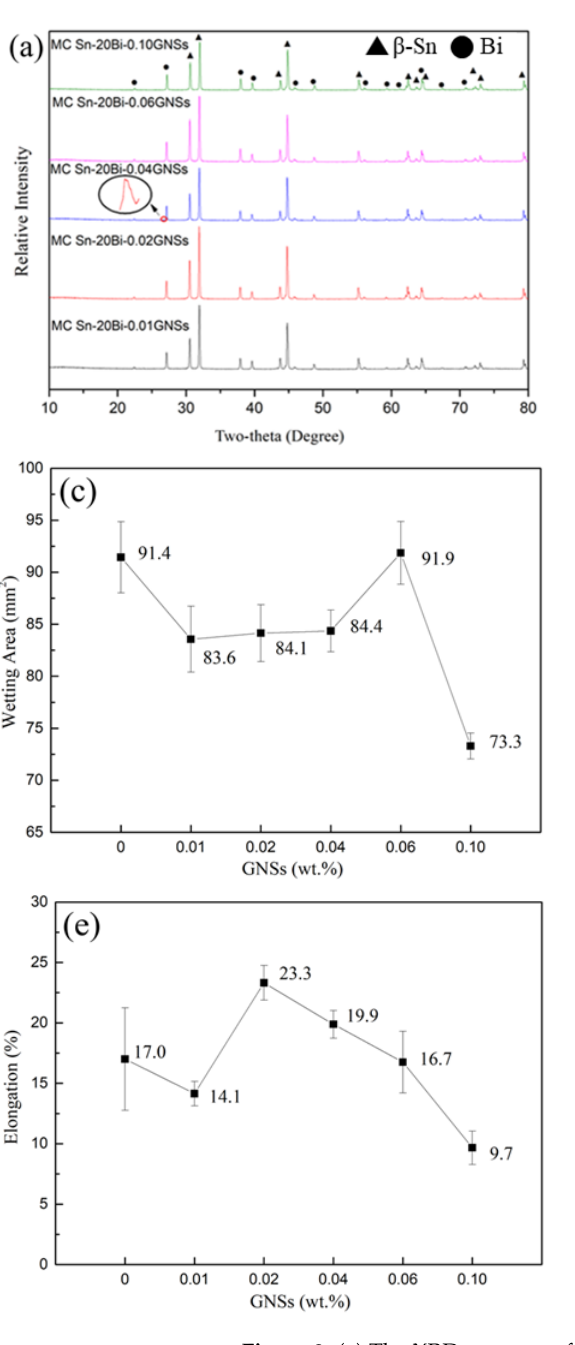
Figure 2. ( a ) The XRD patterns of MC Sn-20Bi- q GNSs ( q = 0.01, 0.02, 0.04, 0.06, 0.10); ( b ) the density of MC Sn-20Bi- q GNSs; ( c ) the wetting area of MC Sn-20Bi- q GNSs alloys; ( d ) the spreading rate of MC Sn-20Bi- q GNSs alloys; ( e ) the elongation of MC Sn-20Bi- q GNSs alloys; and ( f ) the tensile strength of MC Sn-20Bi- q GNSs alloys.